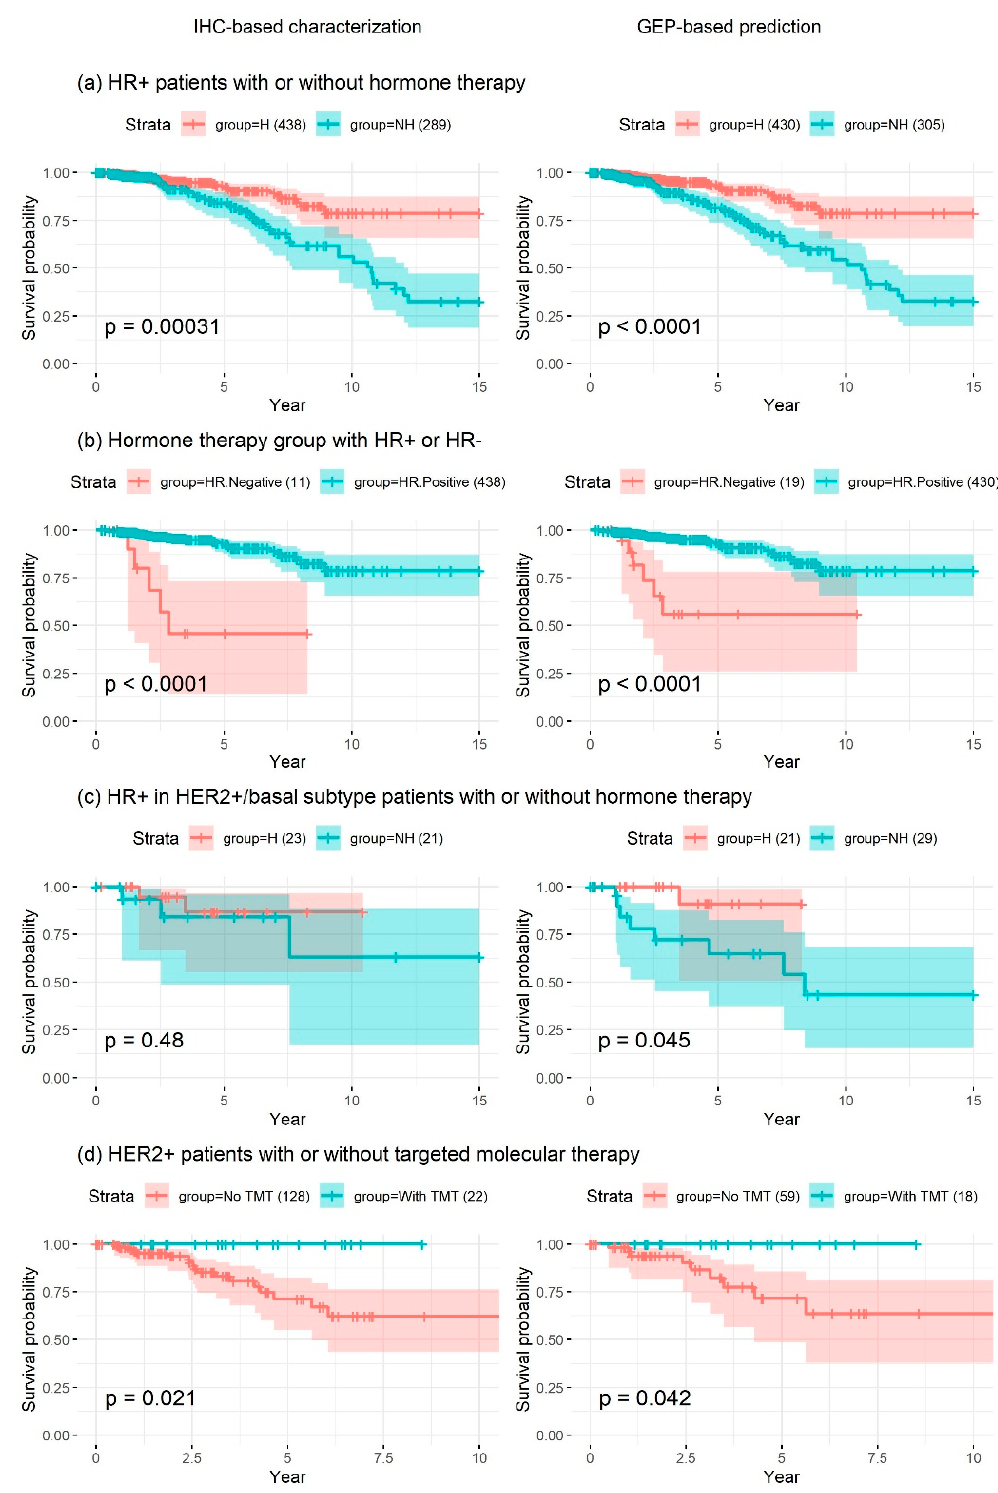
Figure 3. Kaplan–Meier survival analysis of patients from the TCGA dataset using IHC-based (left panel) or GEP-based (right panel) receptor status in the following four patient groups: ( a ) HR + (either ER + or PR + ) group, ( b ) hormone therapy group, ( c ) HR +/ non-luminal subtype group, and ( d ) HER2 + group. Patients were stratified to those who received hormone therapy (H) and those who did not (NH), or those who received targeted molecular therapy (With TMT) and those who did not (No TMT). ( a ) GEP-based receptor status prediction had higher prognostic significance in terms of patient survival compared to IHC-based HR status. ( b ) IHC-based receptor-status characterization was found to be more accurate than GEP-based receptor-status prediction. However, the numbers of samples in